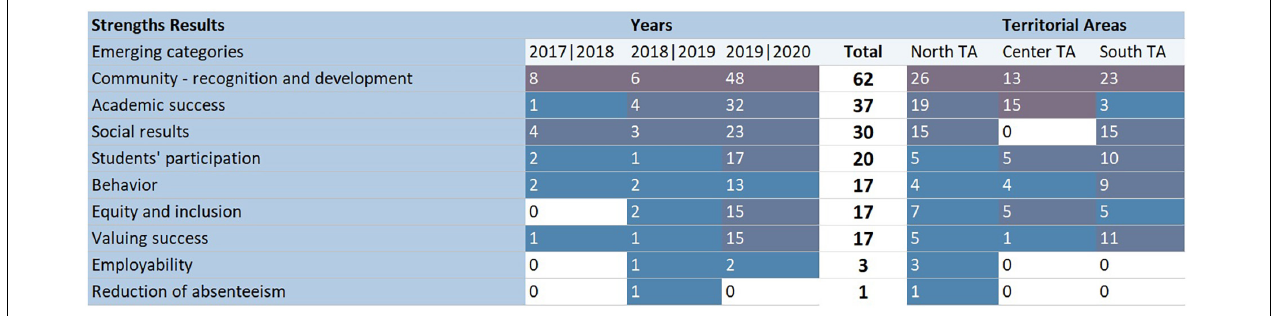
FIGURE 10 | Results: strengths. The distribution of coded segments by subcategories, year, and